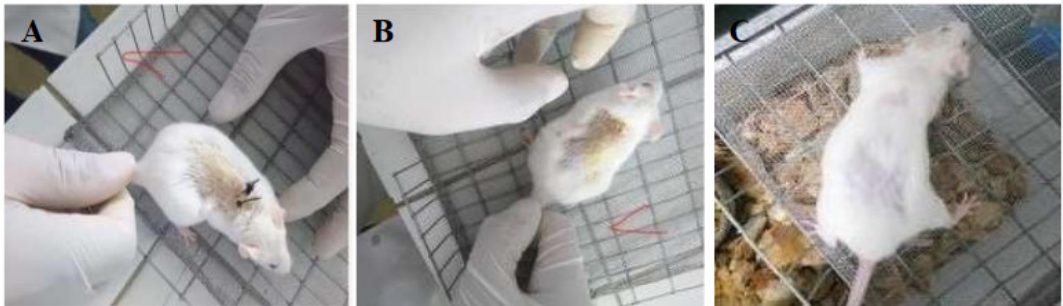
Figure 8. Mice with sisal fiber sutures and the silk control suture (5-0) after one week. ( A ) On Day 8, the sisal suture and commercial silk suture (dark color) remain in position ( B ) Day 8, suture withdrawal from the mouse. ( C ) Day 15, the sisal suture and commercial silk suture (5-0) remain in position. Visually, the recovery of the mice with the sisal fibers and the silk control suture were successful, without physical signs of inflammation.